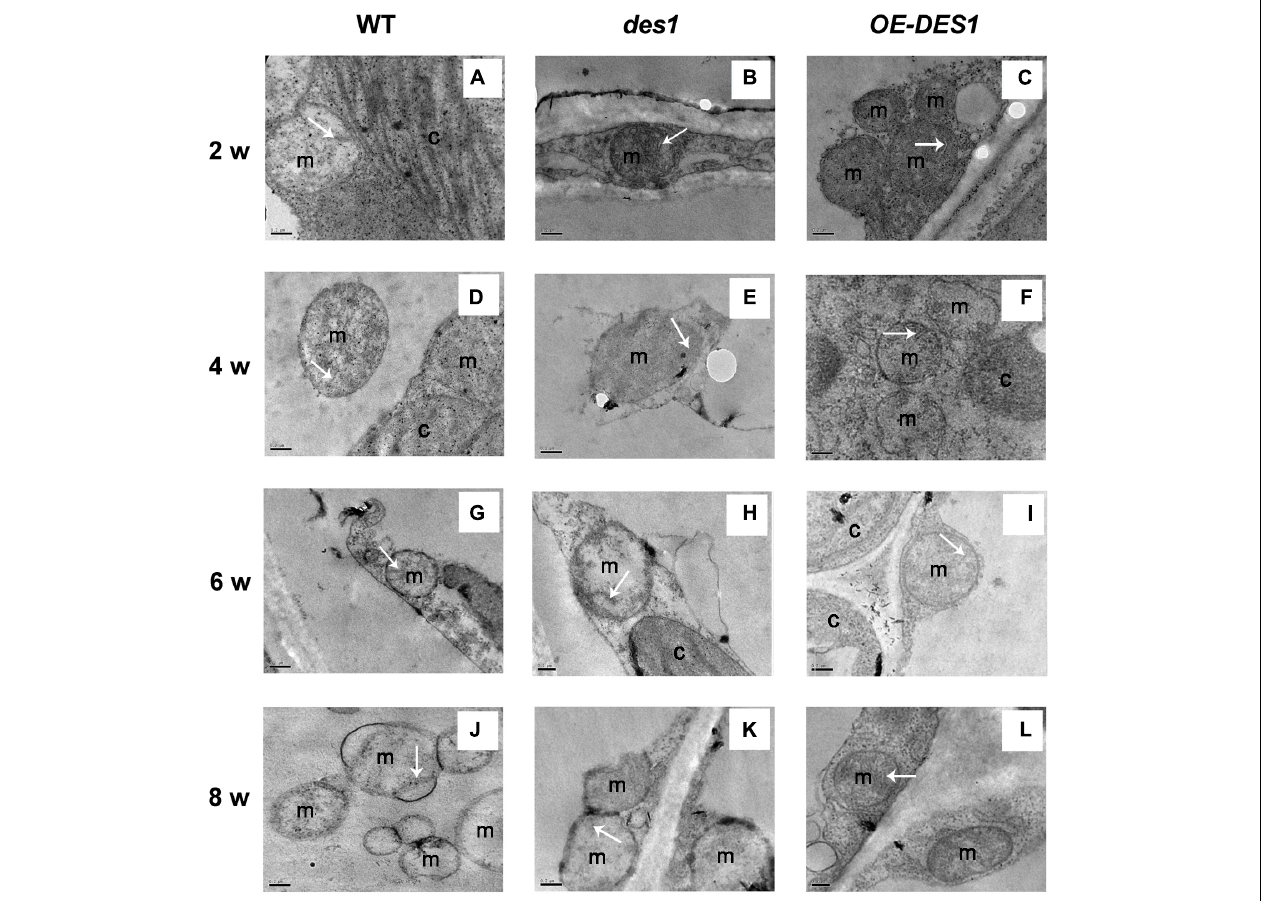
FIGURE 3 | Effects of H 2 S on mitochondrial ultrastructure in WT, des1 and OE-DES1 plants at different developmental stages under drought-stress conditions. The 1-, 3-, 5-, and 7-week-old seedlings were subjected to drought stress by withholding water for 7 days, and then samples of leaves were collected. Ultrastructure of WT (A,D,G,J) , des1 (B,E,H,K) , and OE-DES1 (C,F,I,L) were observed using TEM. Bars = 0.2 µ m. M, mitochondrion; C, chloroplast. The tubular shape or remnants of cristae were labeled by